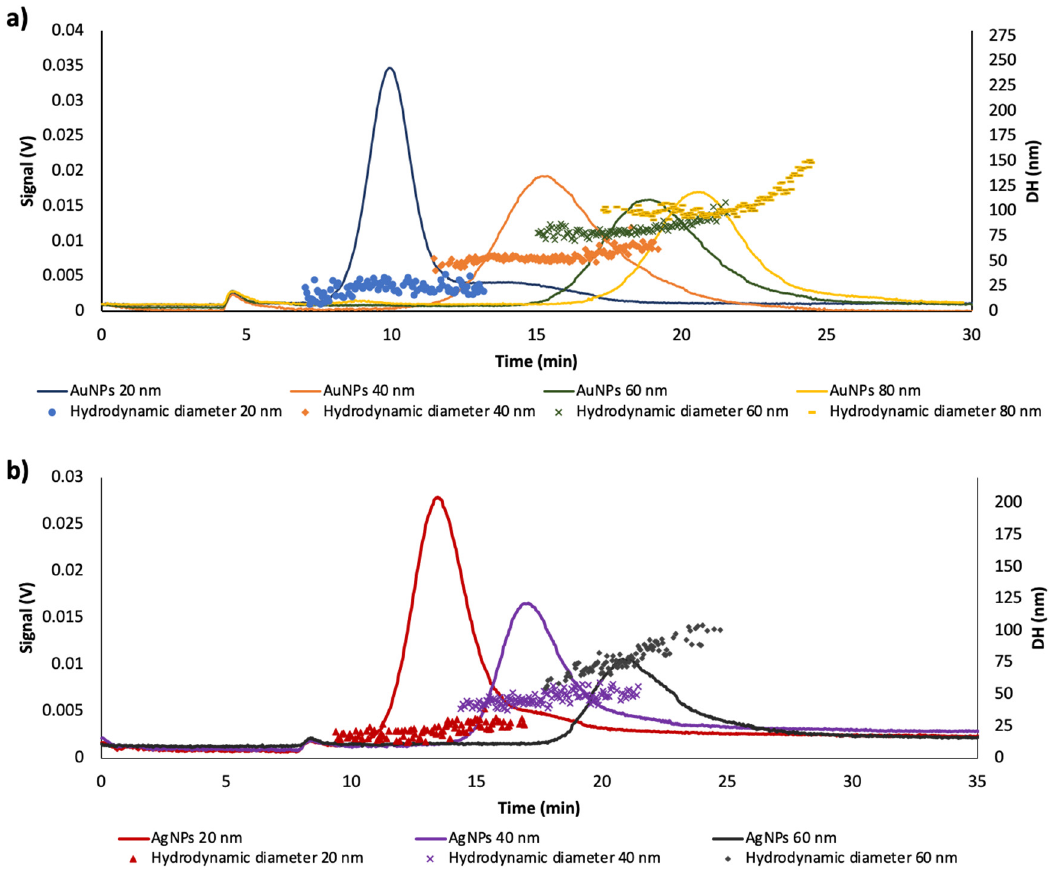
Figure 2. Fractograms for: ( a ) 20, 40, 60 and 80 nm citrate-capped-AuNPs aqueous dispersions (dilution: 1/4) and ( b ) 20, 40 and 60 citrate-capped-AgNPs aqueous dispersions (dilution: 1/4).